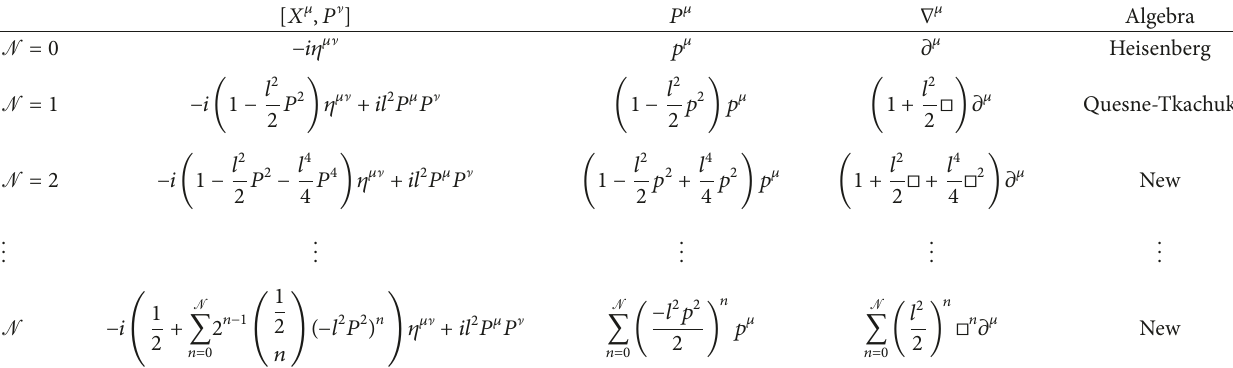
Table 1: Nontrivial commutator and representation for a few truncations of the modified Quesne-Tkachuk algebra. [𝑋 𝜇 ,𝑃 ] ] 𝑃